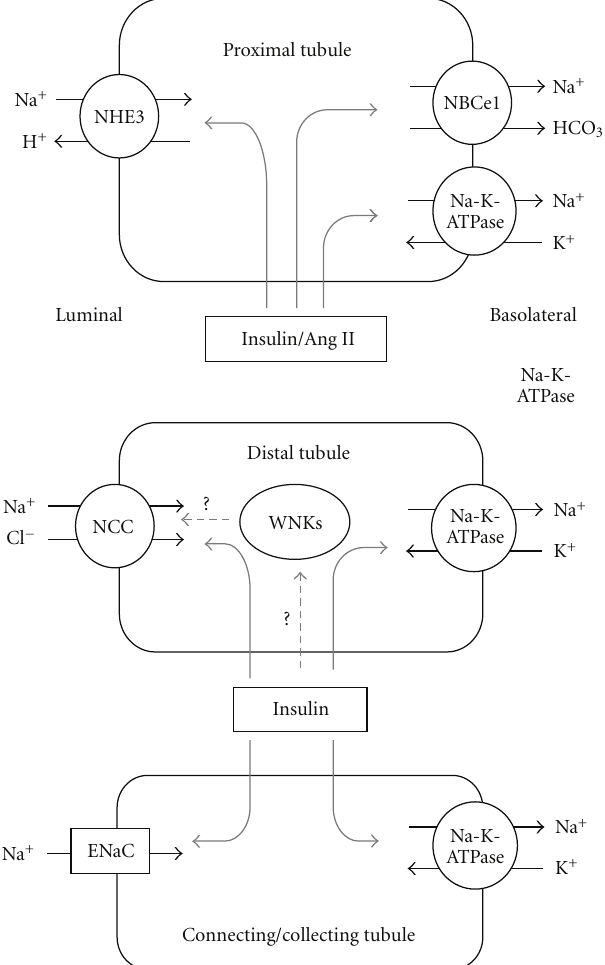
Figure 1: The main sodium transporters and regulators in the proximal tubule and distal and connecting/collecting tubules. In the proximal tubule, insulin and Ang II stimulate NHE3 at the luminal side, NBCe1, and Na-K-ATPase at the basolateral side. In the distal and connecting/collecting tubules, insulin stimulates ENaC and NCC in the luminal side, Na-K-ATPase at the basolateral side. Insulin may also indirectly stimulate NCC via WNK